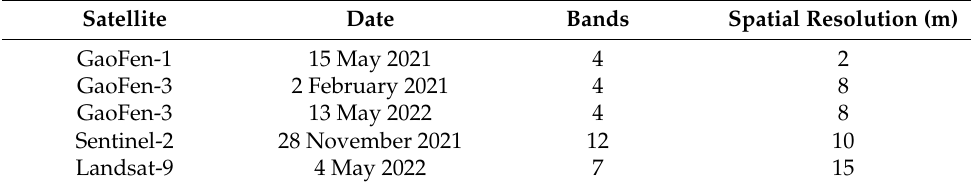
Table 2. Remote sensing data